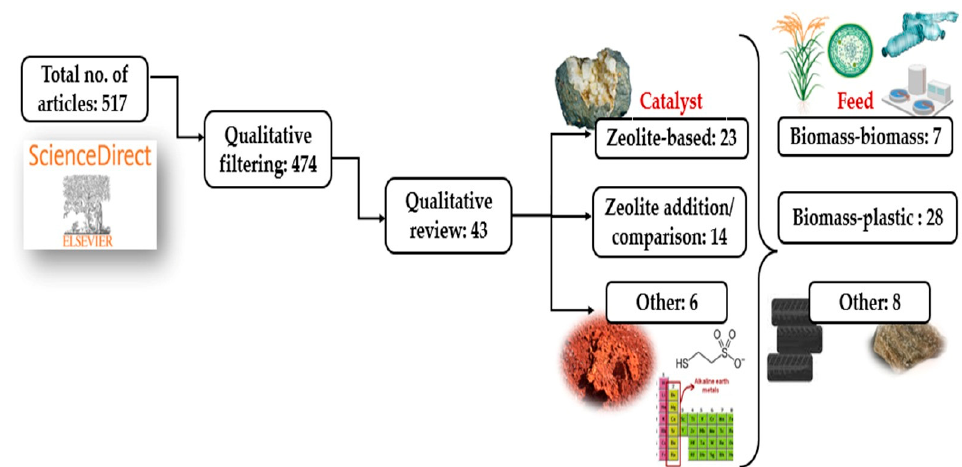
Figure 2. A graphical illustration of the methodology of this review article.